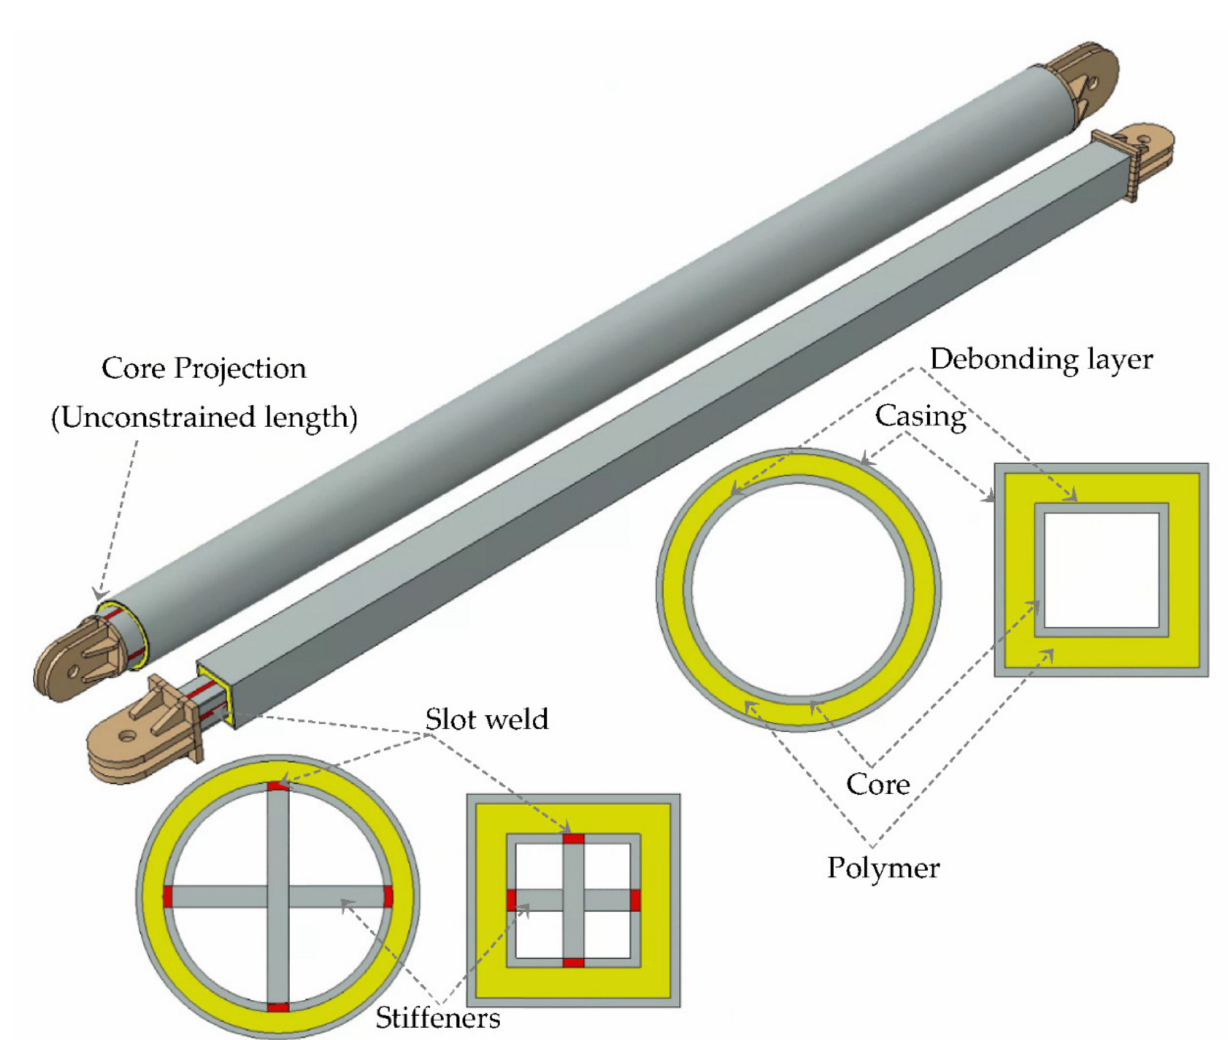
Figure 1. Polymer infilled tube-in-tube buckling-restrained brace.